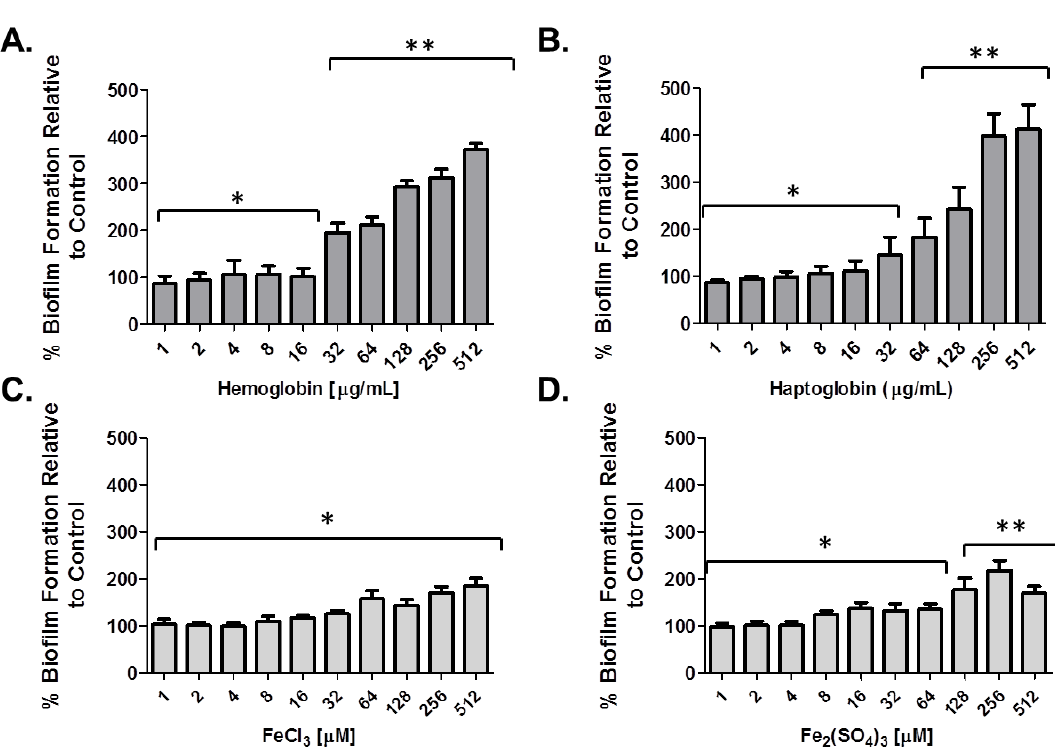
Figure 2. Differential effects of iron sources on biofilm formation of clinical isolates of A. baumannii . Mean increases of biofilm formation of clinical isolates of A. baumannii ( n = 12), as determined by the crystal violet method, relative to untreated controls, in the presence of heme iron (1–512 µg/mL; ( A) and ( B ) and non-heme iron sources (1–512 µM; C and D ) after 24 h. Values are representative of the mean ± SD, of relative % increase of biofilm formation of each of the individual strains to untreated control groups. Experimental assays are representative of at least three independent experiments.